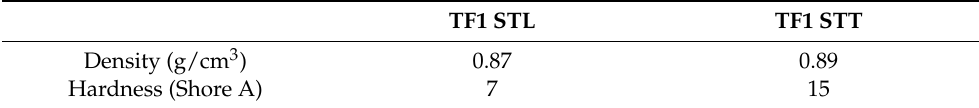
Table 1. TPE matrix